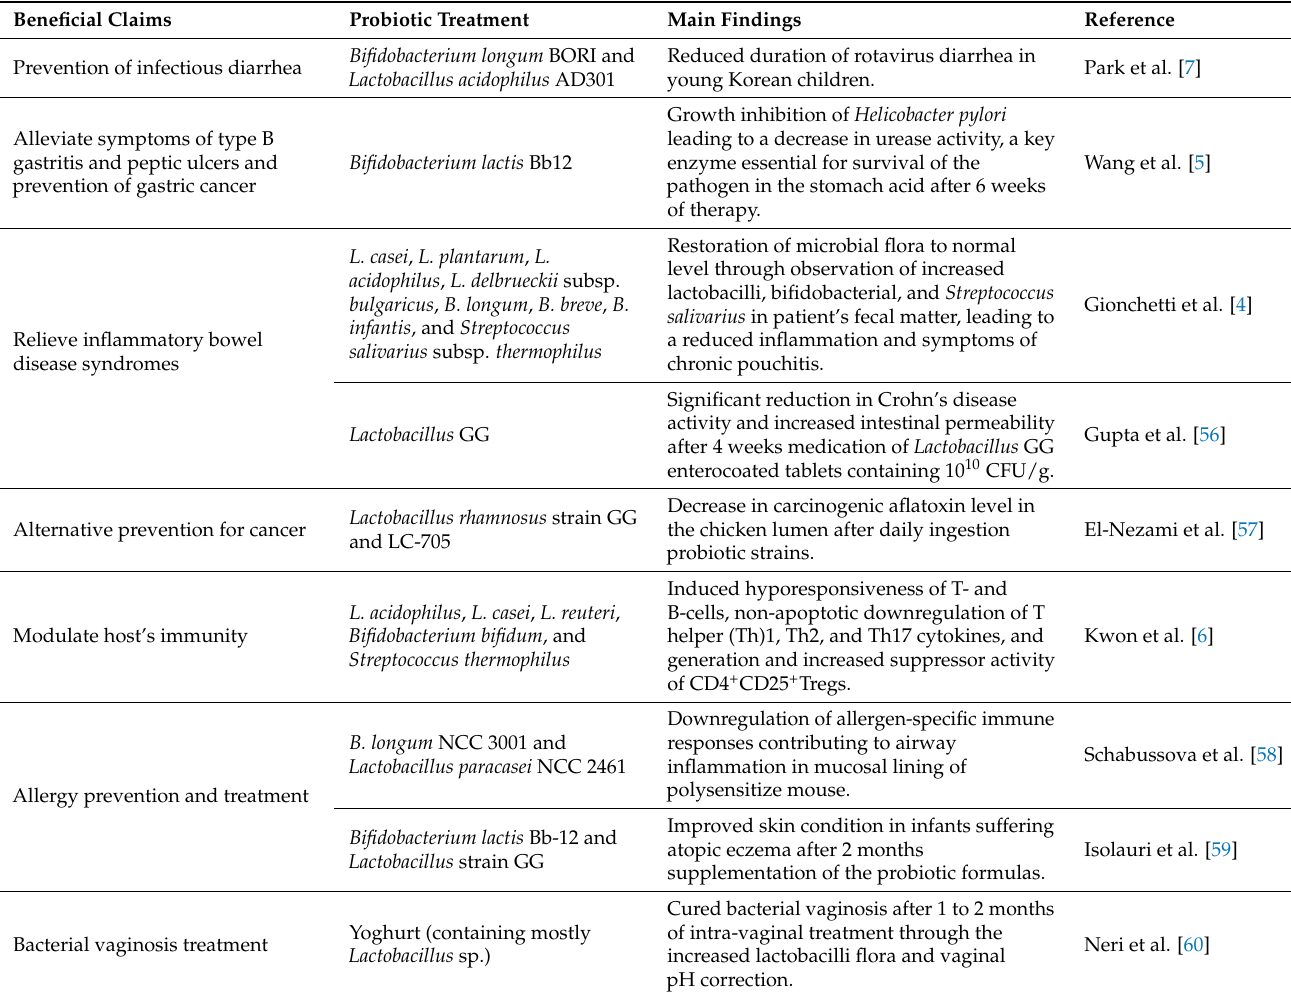
Table 1. Beneficial claims of